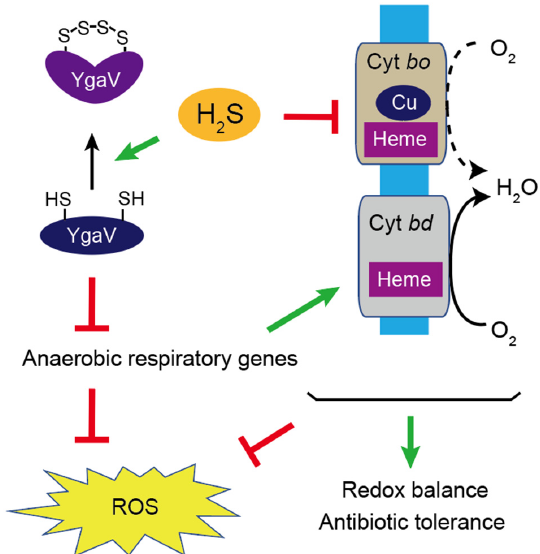
Figure 11. A schematic model for YgaV-dependent control of gene expression and its physiological function. H 2 S inhibits activity of the energy-efficient cytochrome bo oxidase, which causes ROS accu- mulation. In the presence of H 2 S, two cysteine residues of YgaV form an intramolecular tetrasulfide bond to derepress anaerobic-respiratory and ROS-scavenging genes, which contributes to redox homeostasis, ROS scavenging and antibiotic tolerance. mutant. Specifically, highly expressed katG and cytochrome bd oxidase genes in the ygaV mutant may contribute to ROS scavenging [17]; however, H 2 O 2 levels in the mutant were the same or higher than those in WT before and after antibiotic application (Figure 8C).